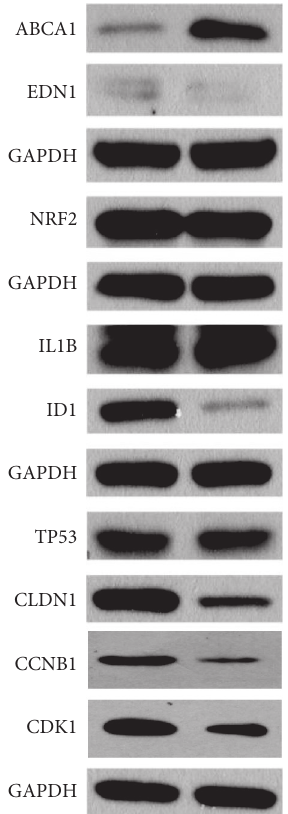
Figure 4: The relative expression level of ABCA1 was significantly higher in HaCaT cells stimulated with 200 μ g/ml PM2.5 for 24h and that of ID1 was significantly higher in control group (Figure 4). However, no significant difference remained in the expression of END1, CLDN1, TP53, NRF2, and IL-1 β between PM2.5-stimulated HaCaT cells and control